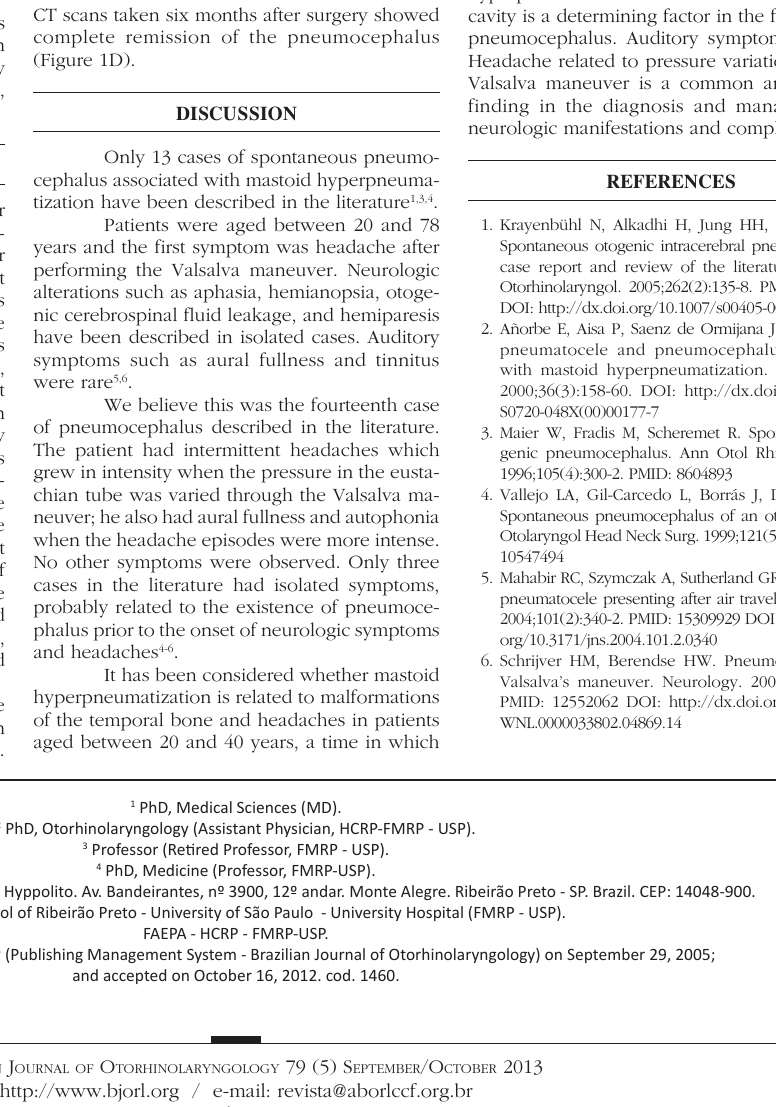
Figure 1. A: CT scan showing the communication between the mastoid cavity and the posterior fossa; B: Intraoperative image of a mastoidectomy showing the communication between mastoid air cells and the posterior fossa (A); C: occlusion with a temporal muscle pedicled flap; D: Six months after surgery: closure of the communication, occlusion of the mastoid and middle ear (A) and absorption of the pneumocephalus